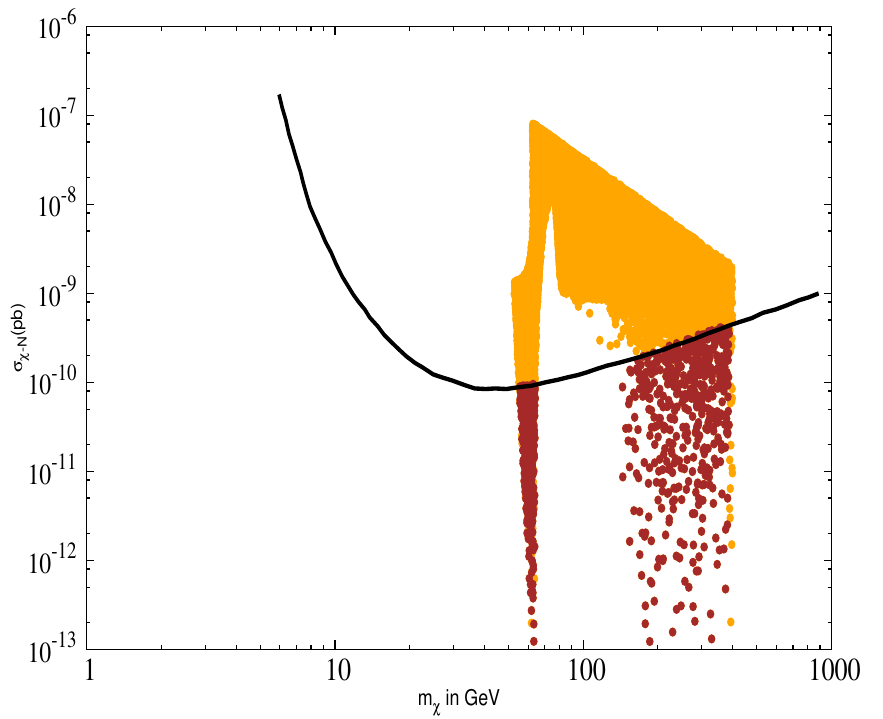
Figure 1 . Parameter space allowed by the relic density observation. The black line is the upper limit on the (cid:31) (cid:0) N scattering cross-section from XENON1T